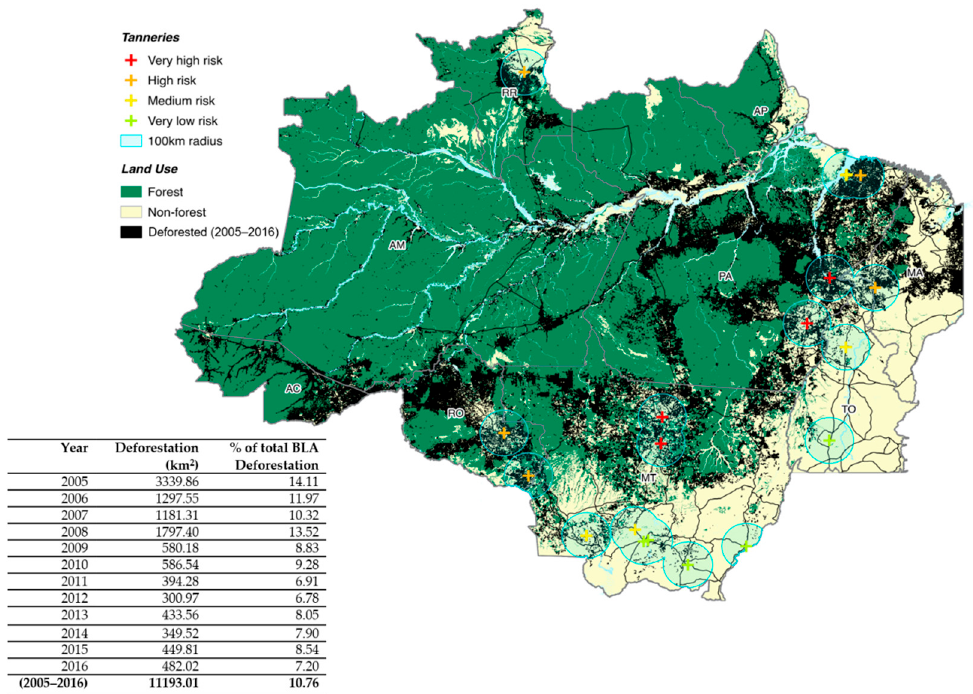
Figure 2. Tannery locations within the BLA and the risk associated with their proximity to defor- estation between 2005 and 2016. The insert table summarizes the BLA deforestation (km 2 ) within 100 km radius from tannery location and incidence of total BLA deforestation for the period. Source: reproduced from Sartorato [109] with permission from Sartorato S.F. C., 2022. (see Appendix B for further methodological details).